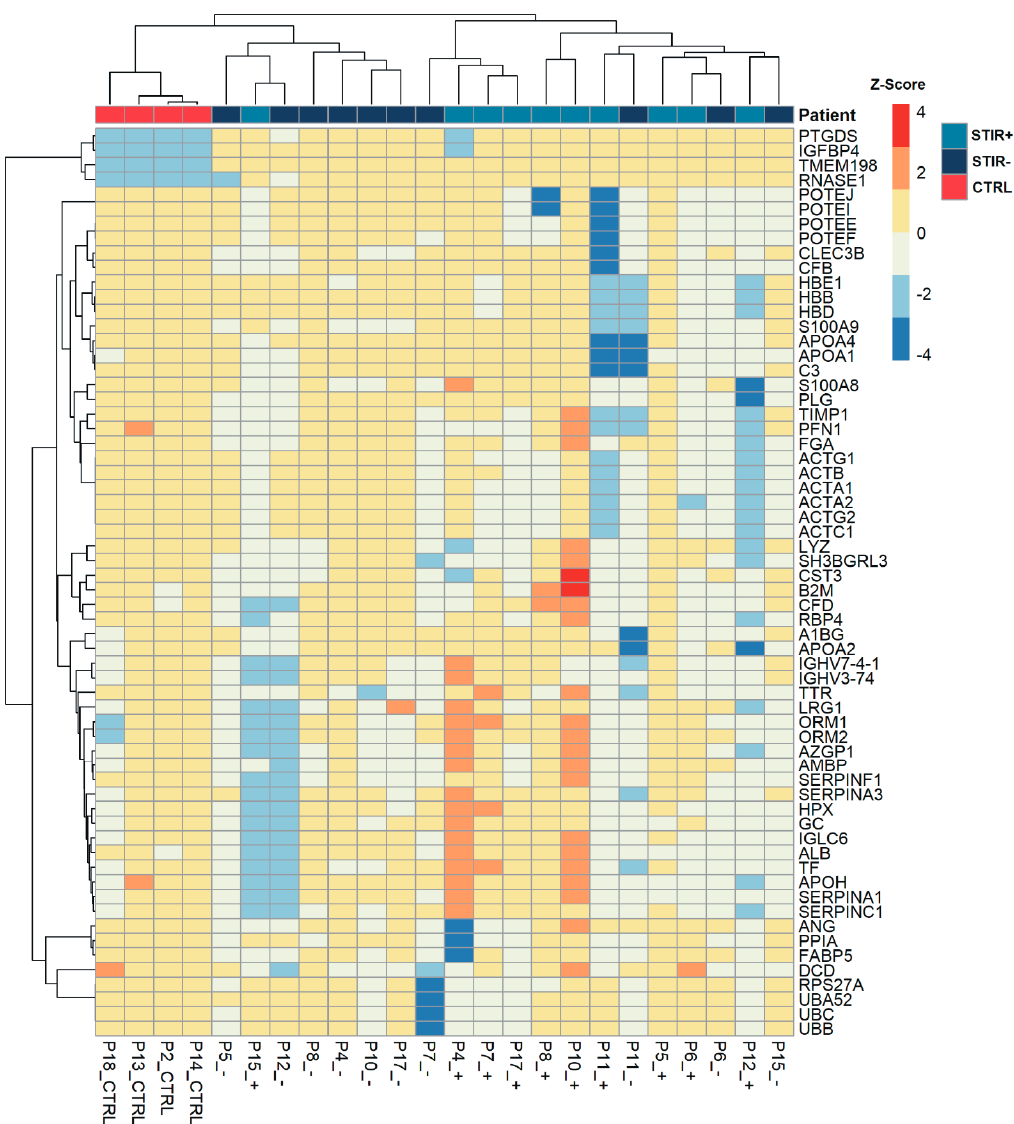
Figure 4. Heatmap showing the expression level of the proteins in STIR+, STIR- and control samples. The paired analysis of samples obtained from the STIR+ and contralateral STIR- mus- cle of the same patient confirmed a significant dysregulation of eight proteins (Supple- mentary Figure S1). Other proteins of possible interest, such as components of comple- ment system (Complement C1q subcomponent subunit B (P02746); Complement C1r sub- component (P00736); Complement C1s subcomponent (P09871); Complement component C8 gamma (P07360) and beta (P07358) chains) [12] were identified only in a in small num- ber of STIR+ samples; several C-C motif chemokines (14, 18, 21, and 27) were also upreg- ulated in the STIR+ samples analyzed, even if not reaching statistical significance (Supple- mentary Table S3).